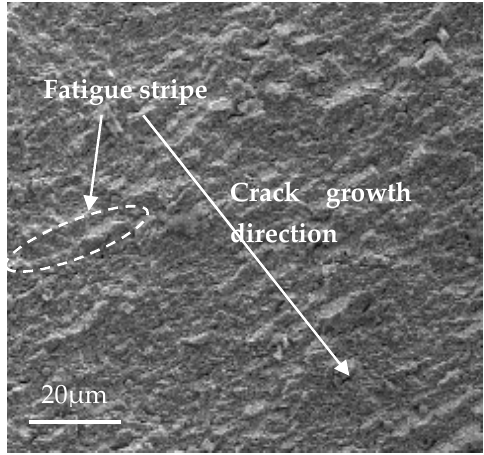
Figure 12. Mesoscopic morphology of Region A—slow extending region.